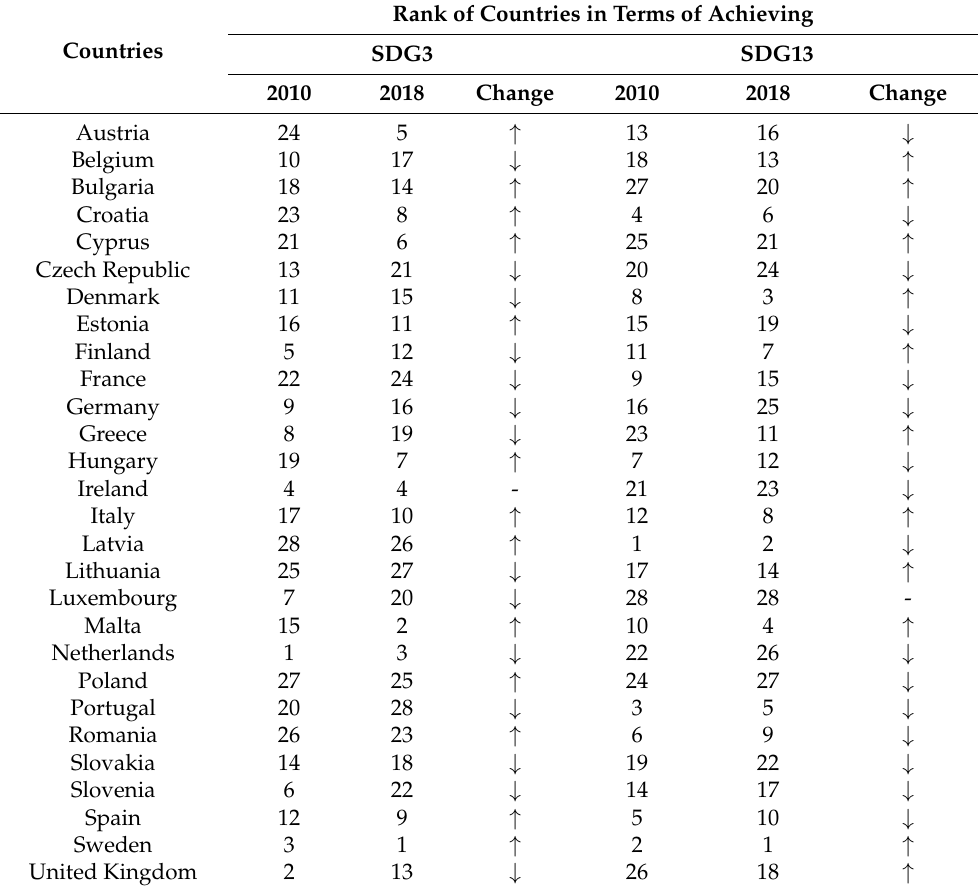
by an average of 3.35 percentage points each year. Of all the countries surveyed, Sweden also has the highest share of renewable energy in gross final energy consumption by sector, which is 2.5 times higher than the average for all countries. Table 5. Ranking of EU countries according to the degree of implementation of SDG3 and SDG13 in 2010 and